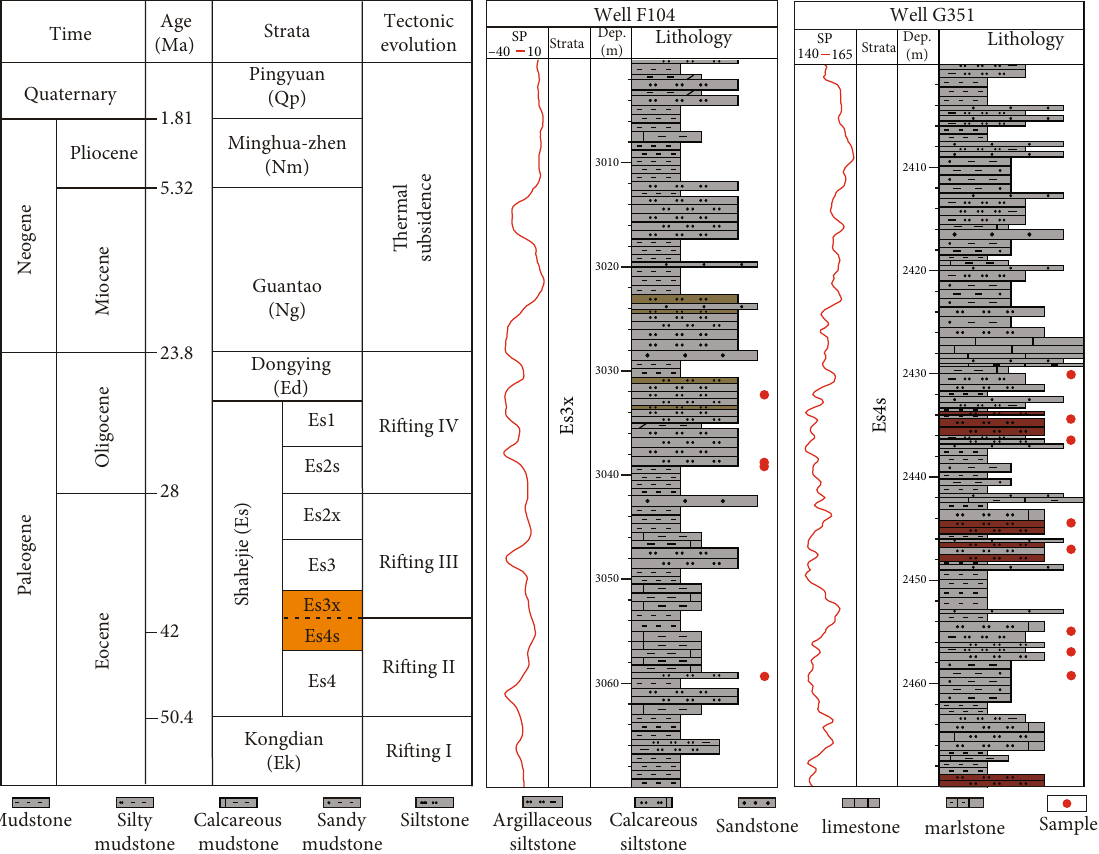
Figure 2: Tertiary stratigraphy and tectonic evolution of the Dongying Depression; sedimentary sequence of wells F104 and G351 in the Es3x and Es4s, respectively, and their locations are shown in Figure 1(b). Table 1: Thin-section compositions from optical point counting and quantitative image analysis. Well Strata